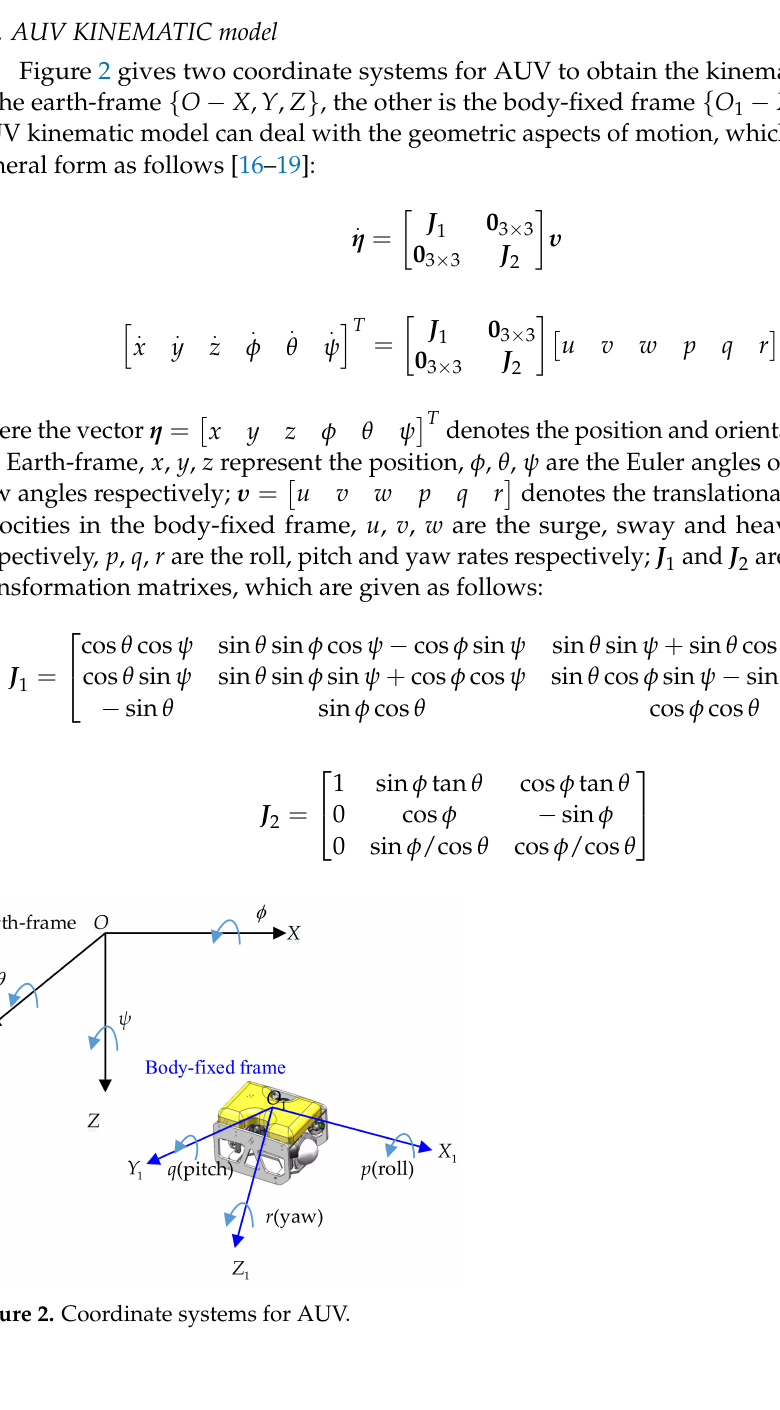
Figure 1. Design process of thruster fault diagnostics and fault tolerant control for AUV.